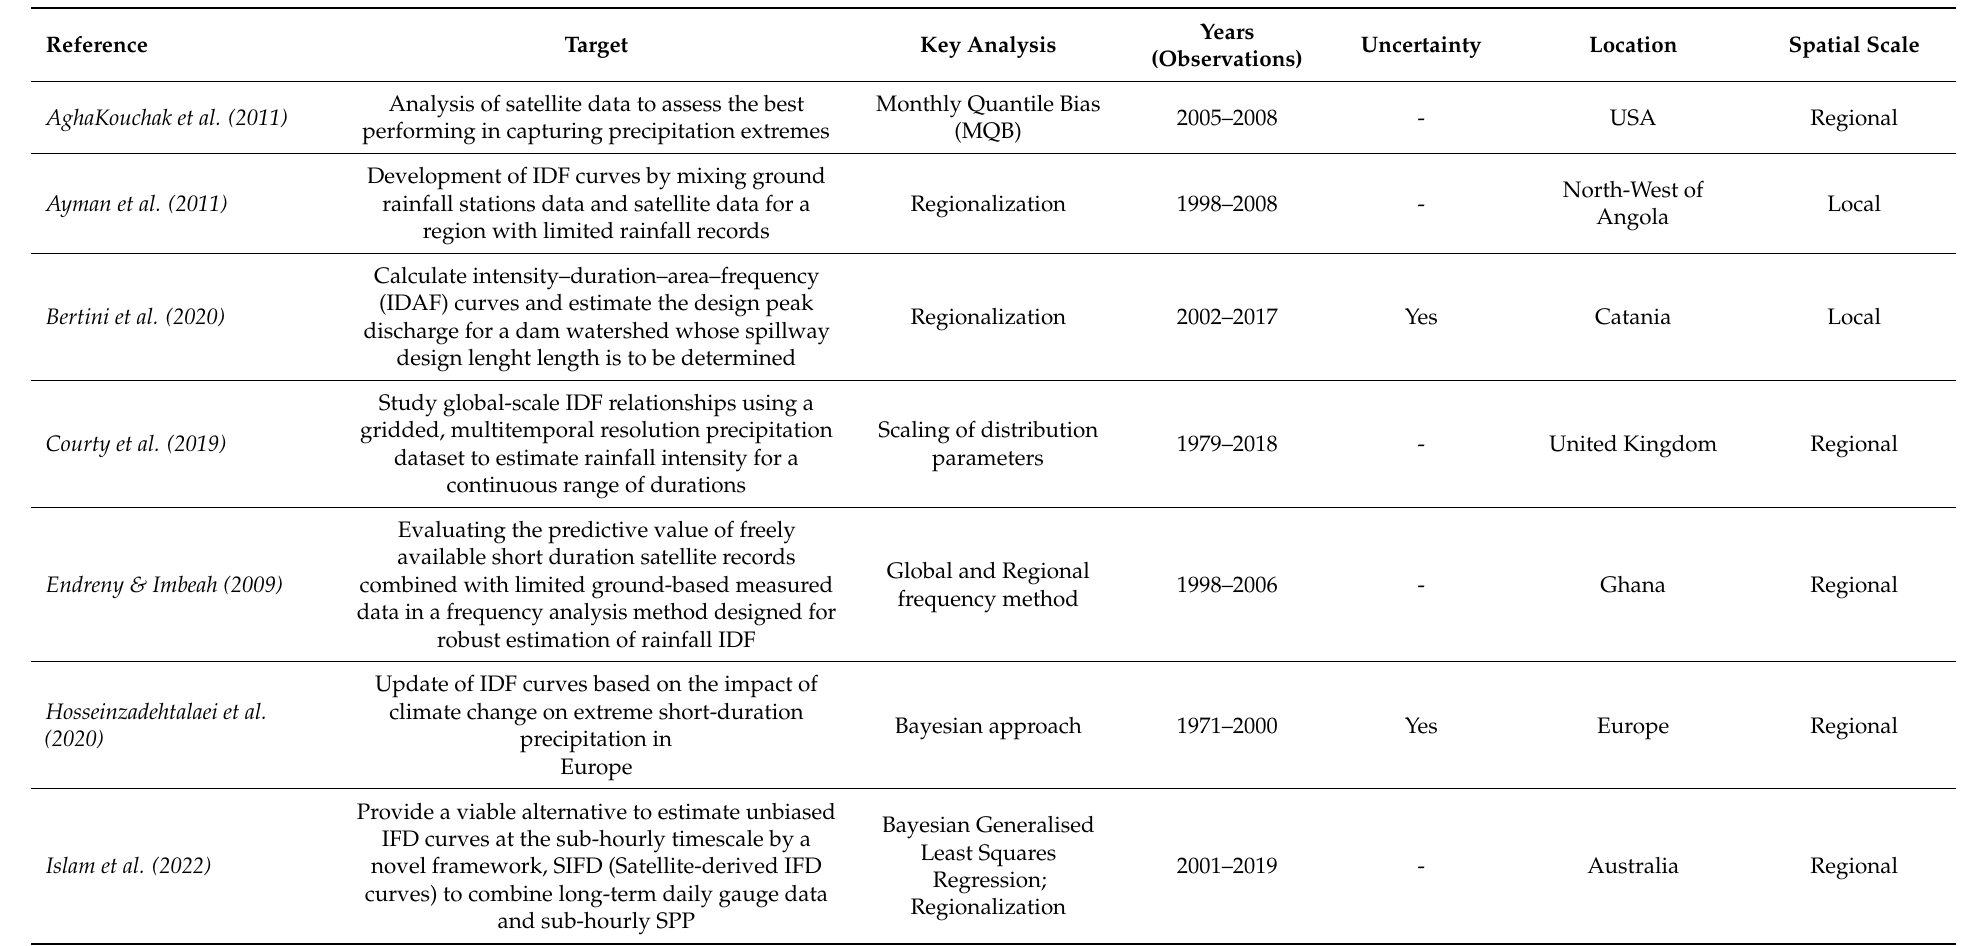
Table 4. Papers developing IDFs using a satellite